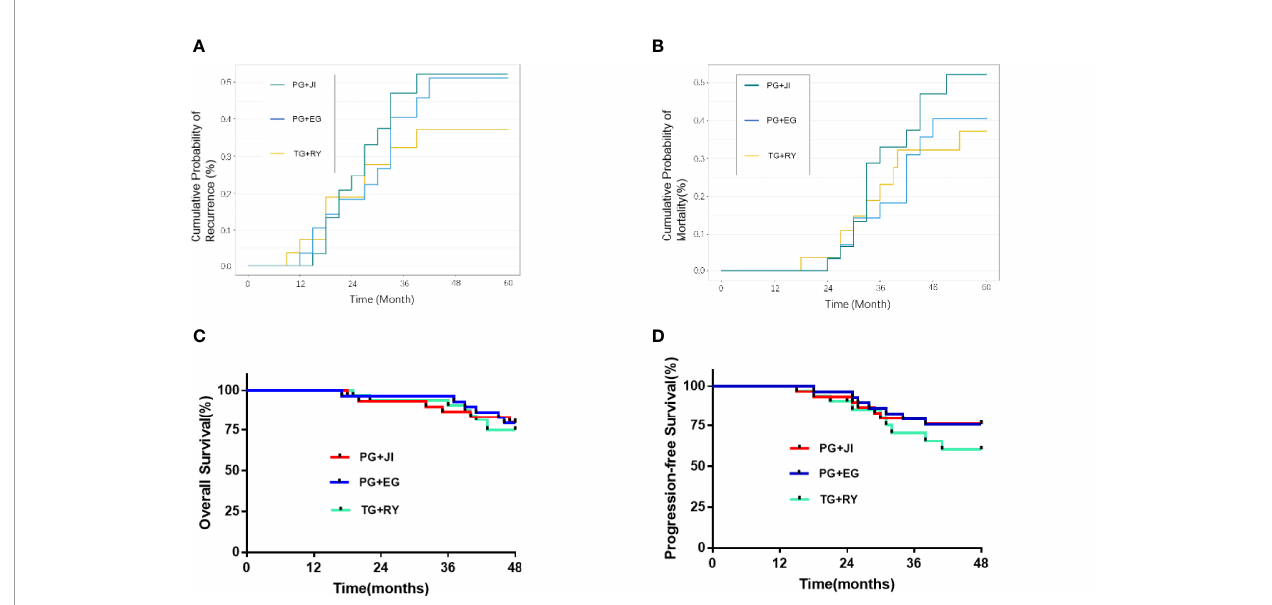
FIGURE 4 | (A) Cumulative probability of recurrence. (B) Cumulative probability of mortality. (C) Overall survival. (D) 5-year progression-free